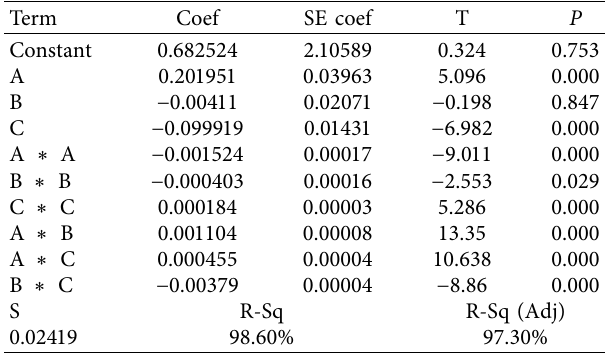
Table 8: Coefficients of estimated regression for surface roughness, Ra. Term Coef Constant